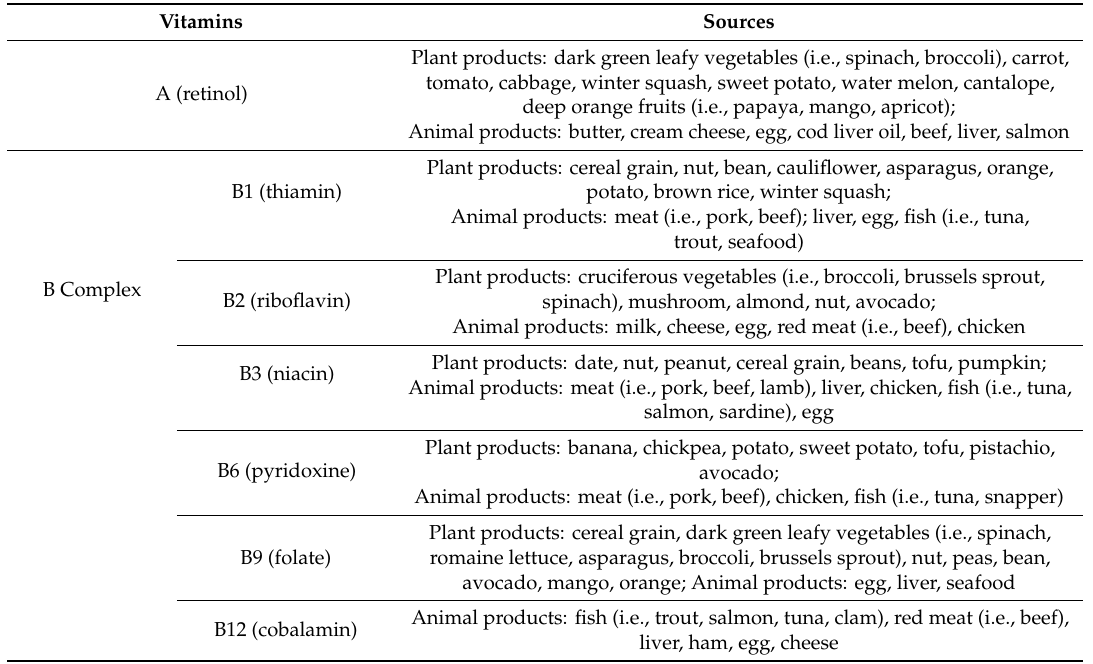
Table 1. Main sources of